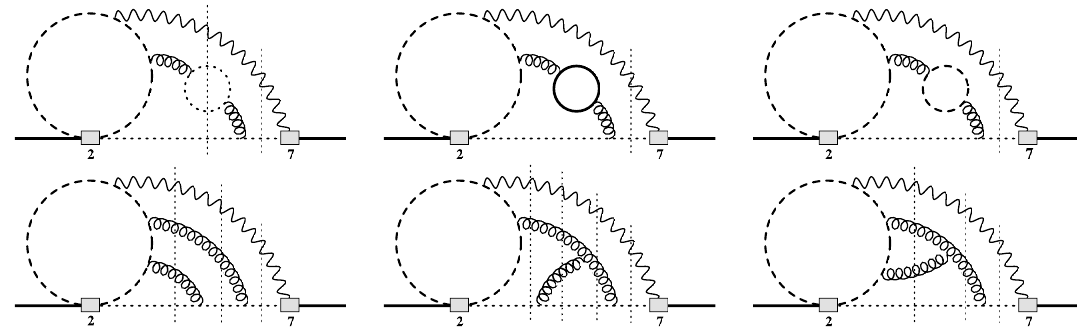
Figure 1 . Sample Feynman diagrams contributing to ^ G (2) indicate possible unitarity cuts. The dotted, dashed and solid propagators correspond to quarks with masses 0, m c and m b ,